Question: What kind of plot is shown here?
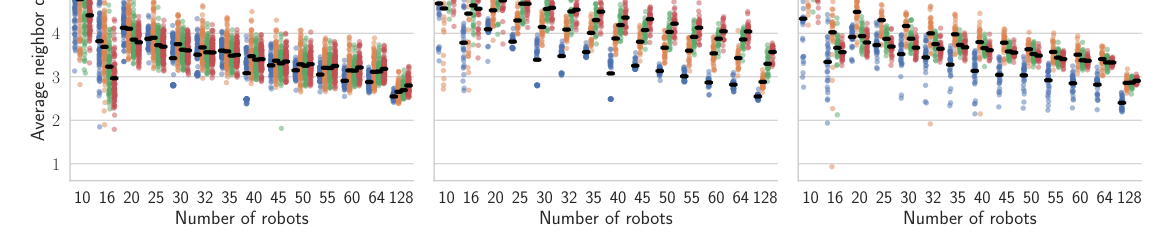
Answer: line